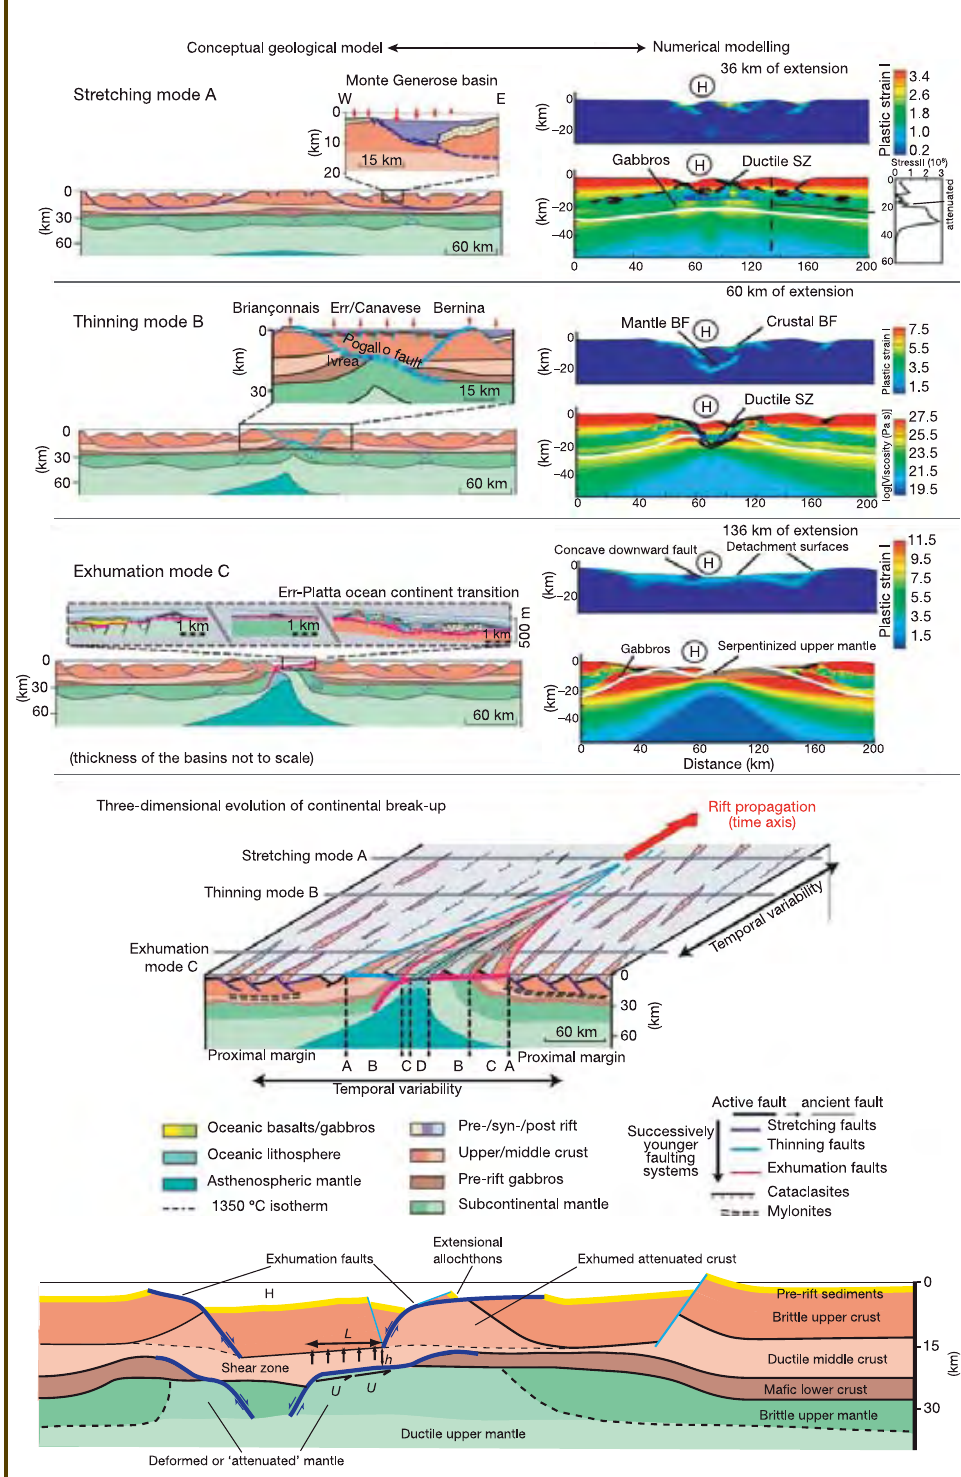
Figure 3. Modeling of the evolution of a continental rift in space and time, not including decompression melting, to better understand the hyper-extended margins of Newfoundland and Iberia (Lavier and Manatschal, 2006). (upper and middle) Conceptual geological and numerical models for different phases of extension that are distinguished by different styles of deformation. The stretching mode [A] is characterized by listric faulting and differential subsidence of half-grabens. The thinning mode [B] is the least documented of the modes, but it can be characterized by maximum thinning of the lithosphere and the presence of a major ductile shear zone accommodating differential motion (up to 10 km upward) between the upper crust and the lower crust/upper mantle. It is accompanied by relatively little uplift of the rift flanks and subsidence in the hanging wall. The exhumation mode [C] is well documented and distinguished by the exhumation of serpentinized upper mantle from <10 km depth along a downward-concave fault. Note the similarity between the observed and modeled structures. (lower) Conceptual model for the thinning phase during continental breakup. Note that thinning is accommodated by the simultaneous exhumation of middle crust and upper